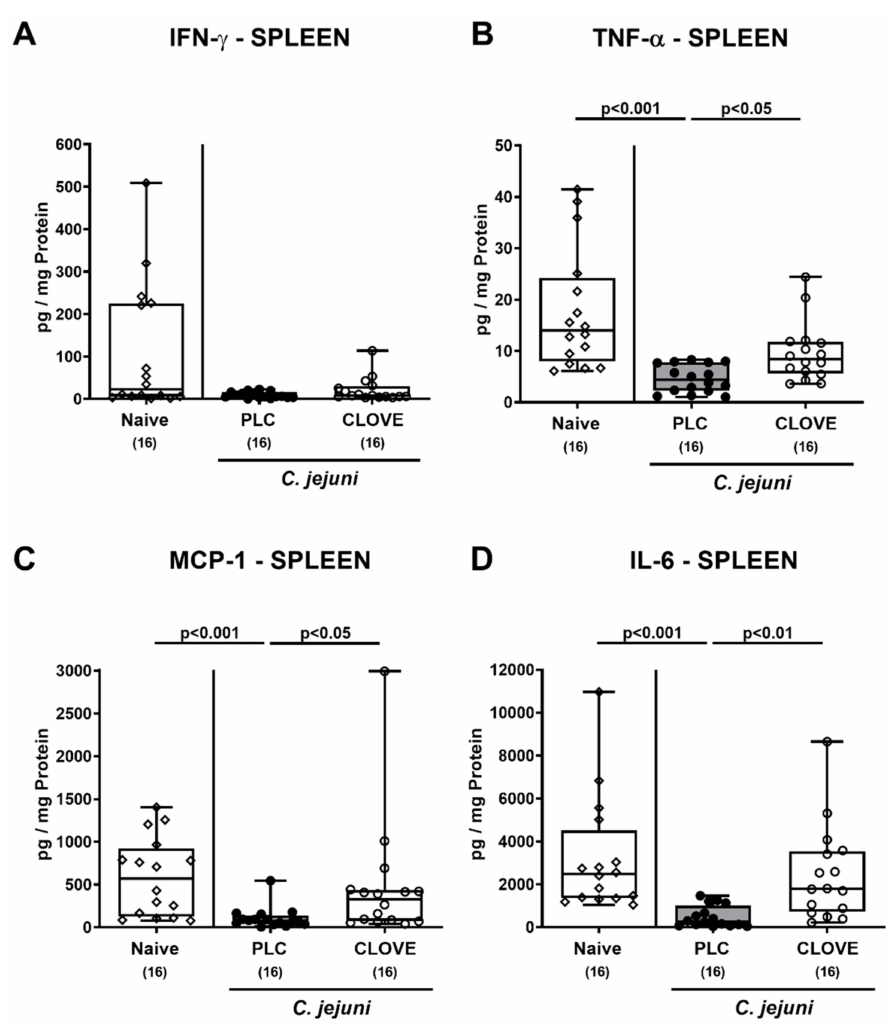
Figure 8. C. jejuni induced splenic proinflammatory mediator secretion following clove EO treatment of infected IL-10 − / − mice. Microbiota-depleted IL-10 − / − mice were perorally infected with C. jejuni strain 81-176 on day (d) 0 and d1. From d2 until d6 post-infection (p.i.), mice were perorally challenged with clove EO or received placebo (PLC) via drinking water. On day 6 p.i., ( A ) IFN- γ , ( B ) TNF- α , ( C ) MCP-1 and ( D ) IL-6 concentrations were measured in ex vivo biopsies derived from the spleen. Box plots indicate the 75th and the 25th percentiles of the median (black bar within box). Naive mice were included as negative control animals. The total range, significance levels ( p values) determined by the Kruskal-Wallis test and Dunn’s post-correction and the total numbers of analyzed mice (in parentheses) are given. Data were pooled from four independent